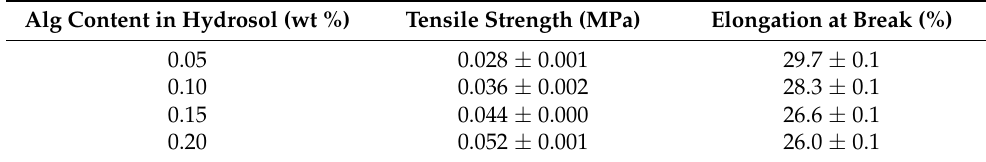
Table 3. Tensile properties of Alg/HA/ICol scaffolds prepared from the hydrosols with different Alg